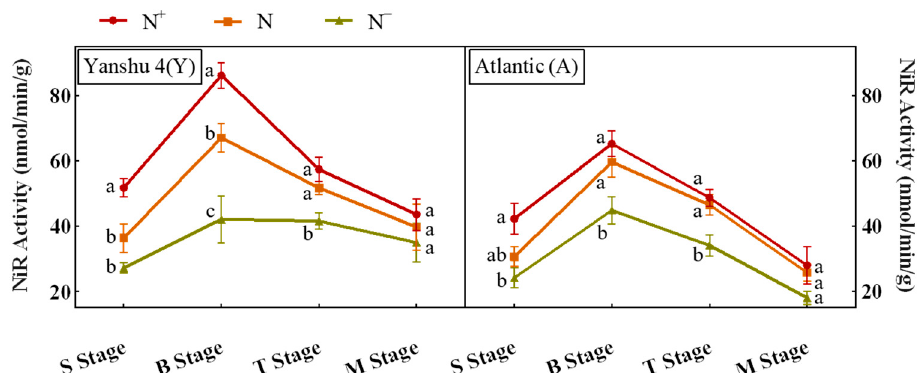
Figure 16. Nitrite reductase (NiR) activity in two genotypes of potato leaves under different N supply levels. The amount of 1 nmol NO 2 − reduced per 1 g of fresh weight sample per 1 min is one unit of enzyme activity. S Stage, B Stage, T Stage, and M Stage represent seedling stage, budding stage, tuber expansion stage, and mature stage, respectively. N − , N, N + are different N supply levels, representing low N, normal N, and excess N, respectively. Different letters indicate the difference of enzyme activity under different N application levels in the same period ( p < 0.05).